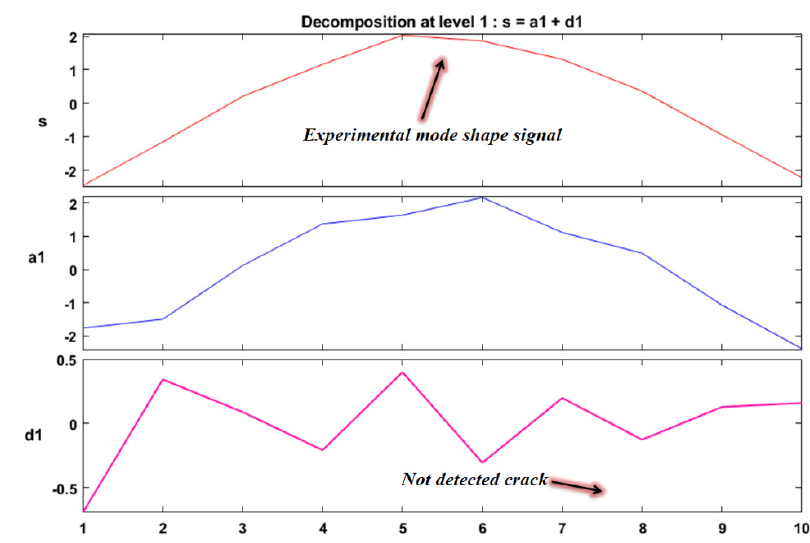
Figure 19. Damage detection by 1D-DWT from experimental damaged mode shape.